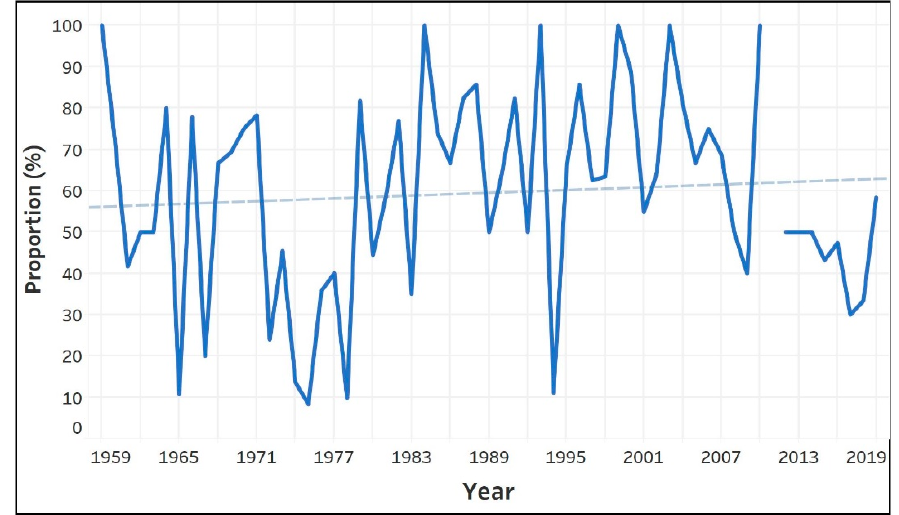
Figure 4. Annual proportion of vehicle-related flood fatalities for all flood fatalities in Texas, 1959–2019 (no flood fatalities occurred in 2011).